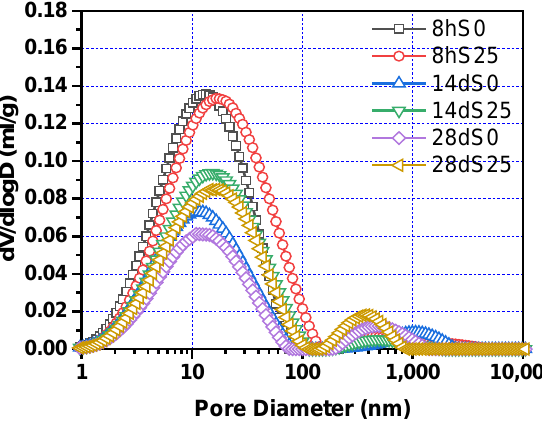
Figure 11. Pore size distribution of S0 and S25 at different times.